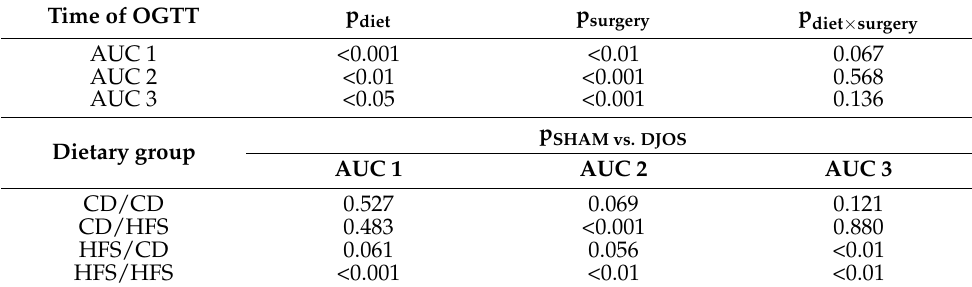
Table 4. Results of contrast analysis of the area under curve (AUC) of the oral glucose tolerance test (OGTT) of Sprague–Dawley rats subjected to control (SHAM) and duodenojejunal omega switch (DJOS) surgery and different dietary regimes at 8 weeks before (AUC 1) and 4 weeks (AUC 2) and 8 weeks (AUC 3) after the surgery. Statistical significance was set at p <